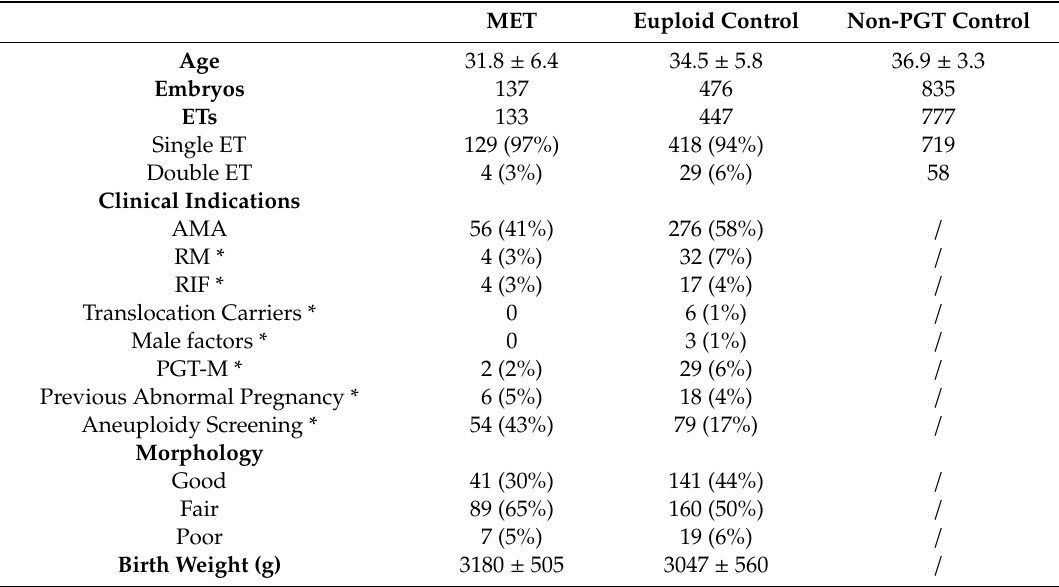
Table 1. Clinical information of studied